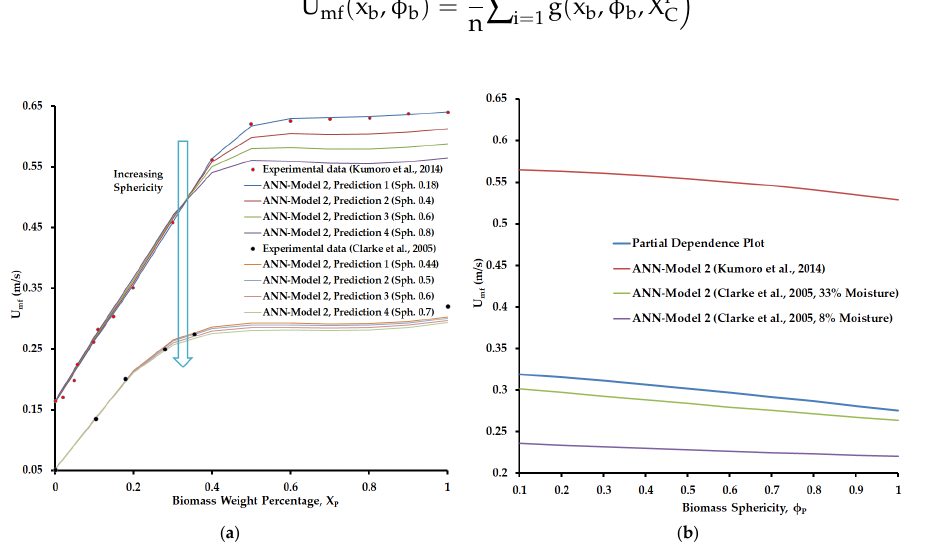
Figure 7. Simulations using Model 2 varying the sphericity values: ( a ) Cases of [32,15]; ( b ) average effect of sphericity calculated with the PDP (x b = 0.4).